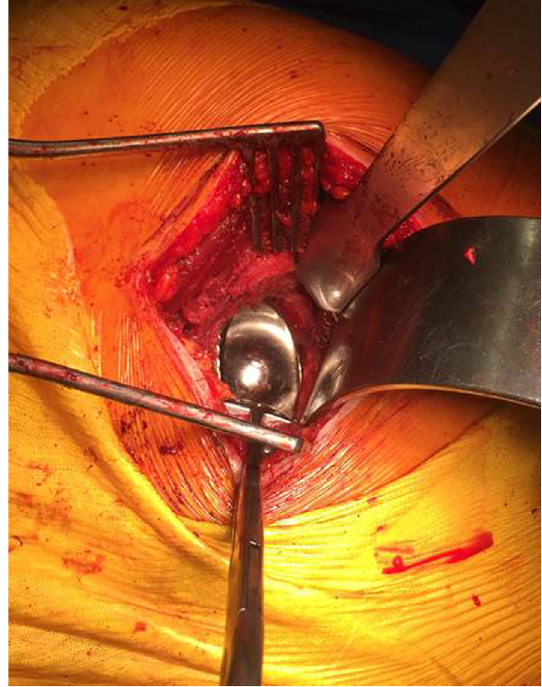
Figure 2. Posterior approach: exposure and cup positioning. One anterior Hohmann retractor is positioned in the anterior horn and a self-retainer, taking out the capsule, is placed close to the posterior horn. The cup is positing in line to the transverse acetabular ligament to restore the anatomic